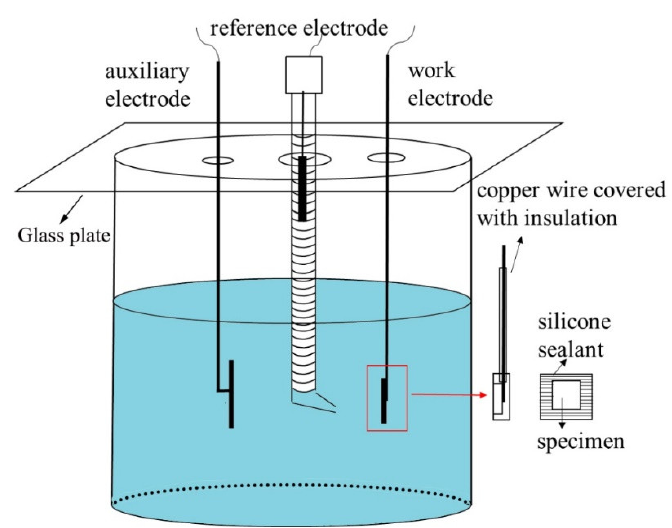
Figure 1. Schematic drawing showing ( a ) the geometry of the 308L-316L welded joint and ( b ) the distribution of microhardness points.